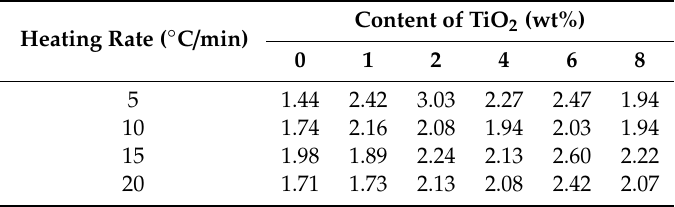
Table 2. Calculated results of the Avrami parameter (n) of different samples. Heating Rate (°C/min)